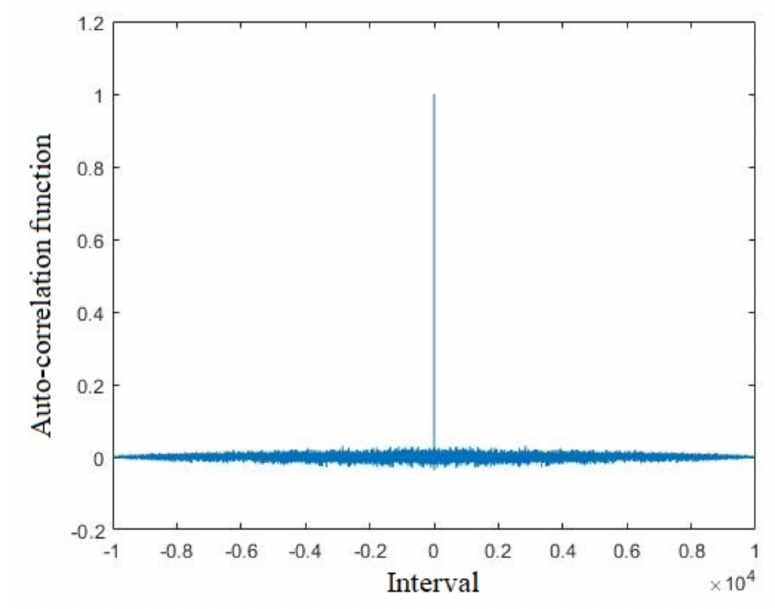
Figure 5. Auto-correlation function of the LB compound chaotic